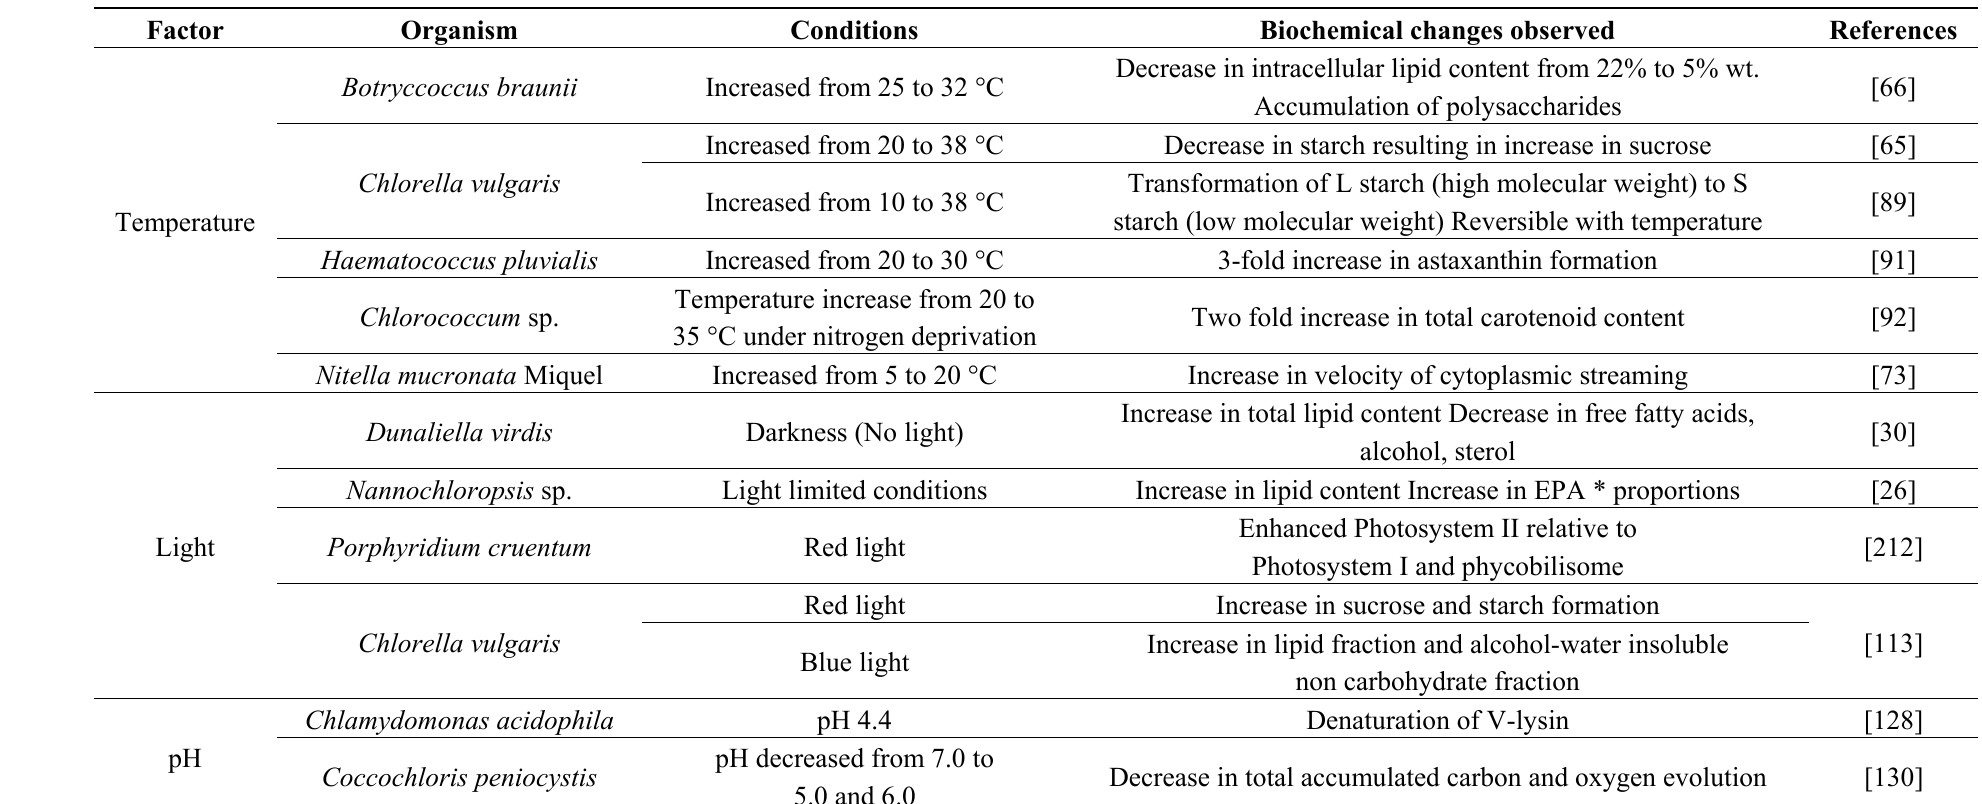
Table 2. Summary of general impact of environmental factors on biochemical composition of